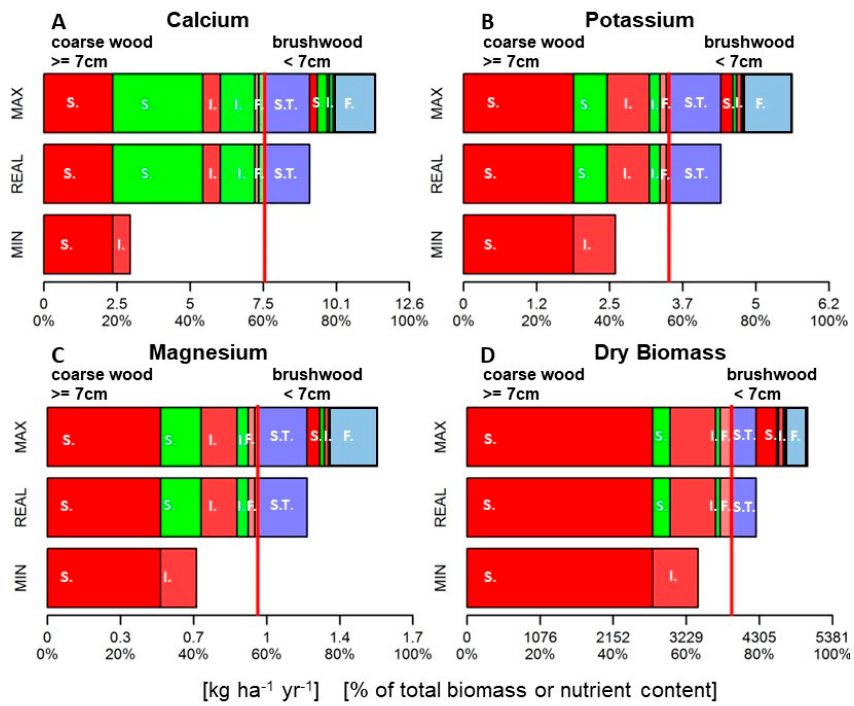
Figure 4. Average export of Ca ( A ), K ( B ), Mg ( C ) and biomass ( D ) at NFI tracts with harvested assortments for the three harvesting intensities MIN, REAL and MAX, differentiated into the biomass compartments wood (red), bark (green) and brushwood with bark (blue). Colour intensity decreasing from stem wood over industrial wood to fuel wood. Harvested wood assortments including bark (minimum diameter ≥ 7 cm) marked by a vertical red line. S.: stem wood, I.: industrial wood, F.: fuel wood, S.T.: brush mat on skid trails.